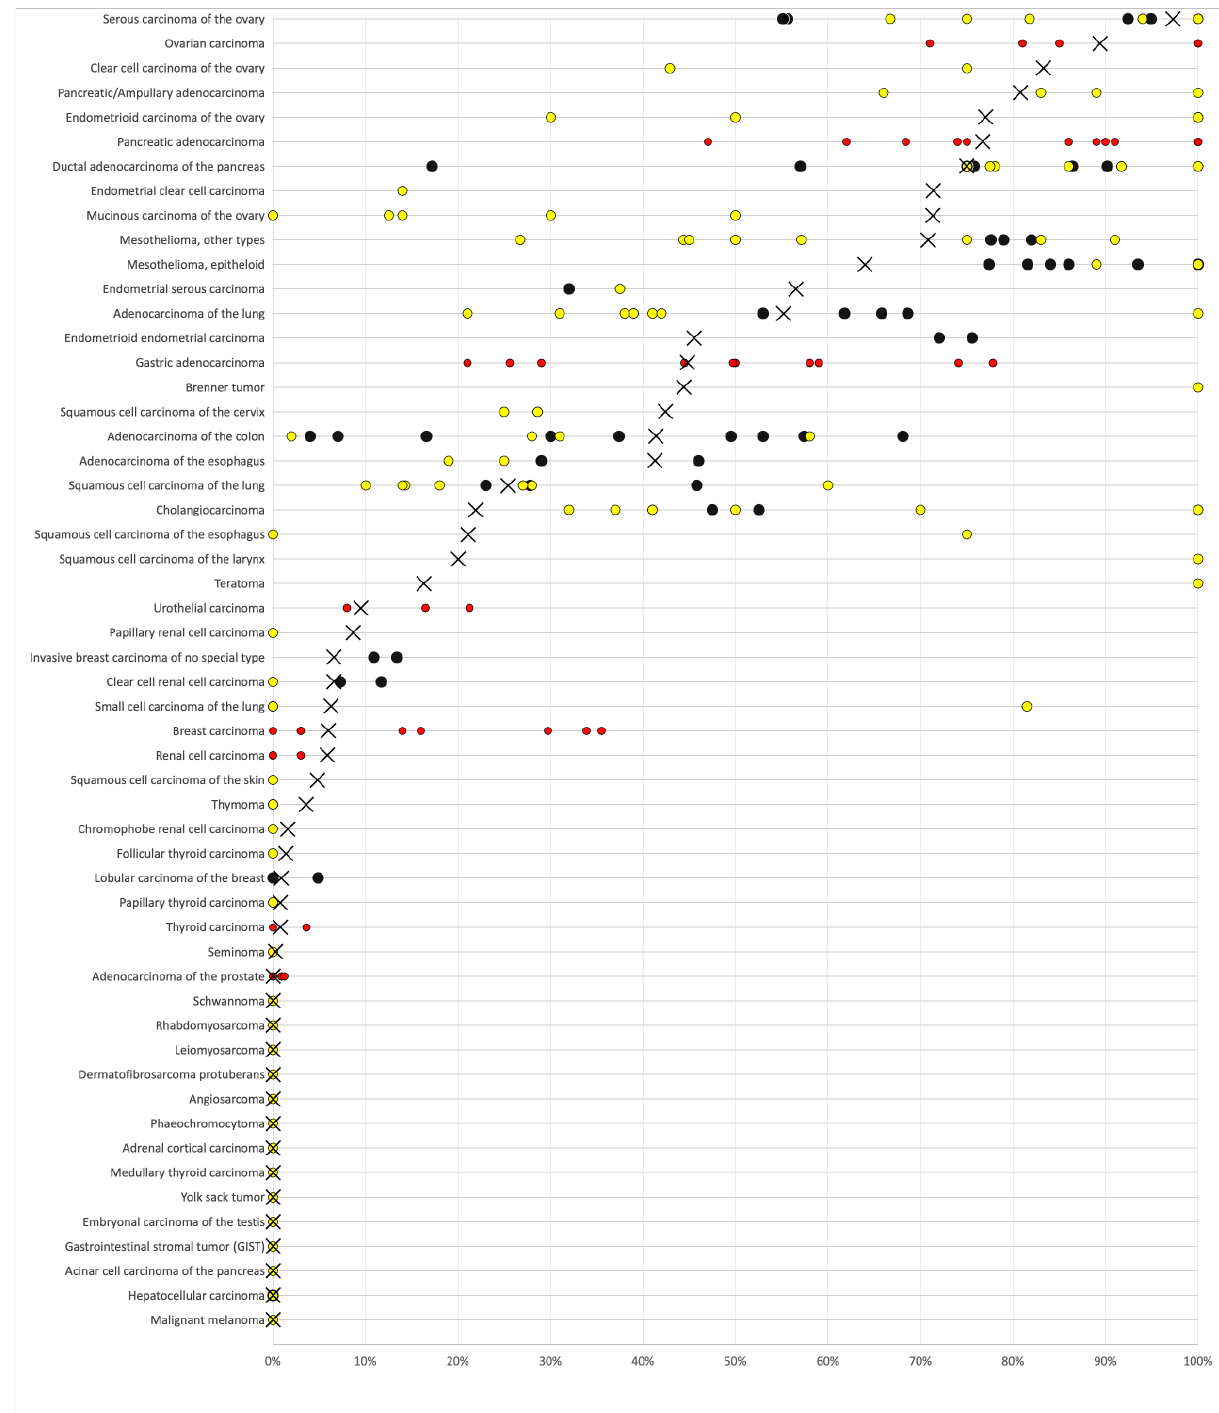
Figure 5. Graphical comparison of MSLN data from this study (×) in comparison with the previous literature. Yellow dots are used for studies involving 1–50 cases, and black dots are used for studies involving more than 50 cases. Red dots are used for studies without subtype analyses. All studies are quoted in the list of references.